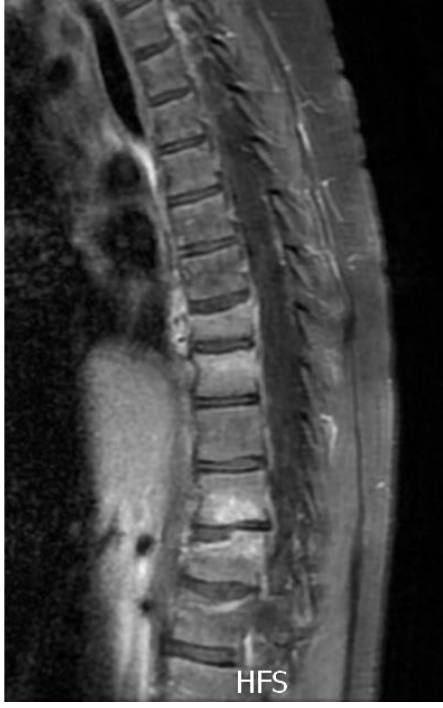
Figure 2. MRI of the spine depicting the vertebral lesions prior to the pamidronate treatment.